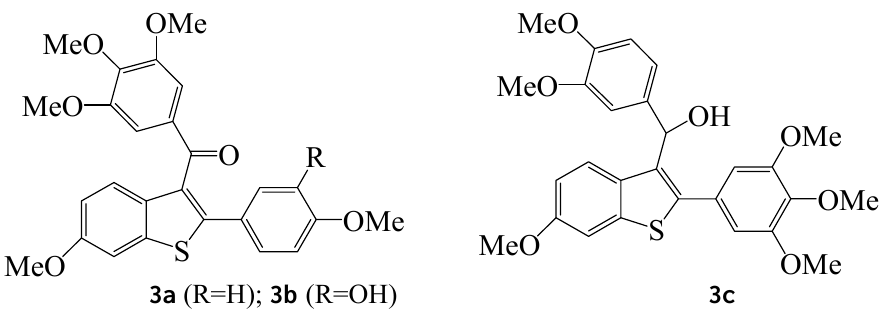
Figure 2. Structures of benzo[ b ]thiophene analogues 3a–c